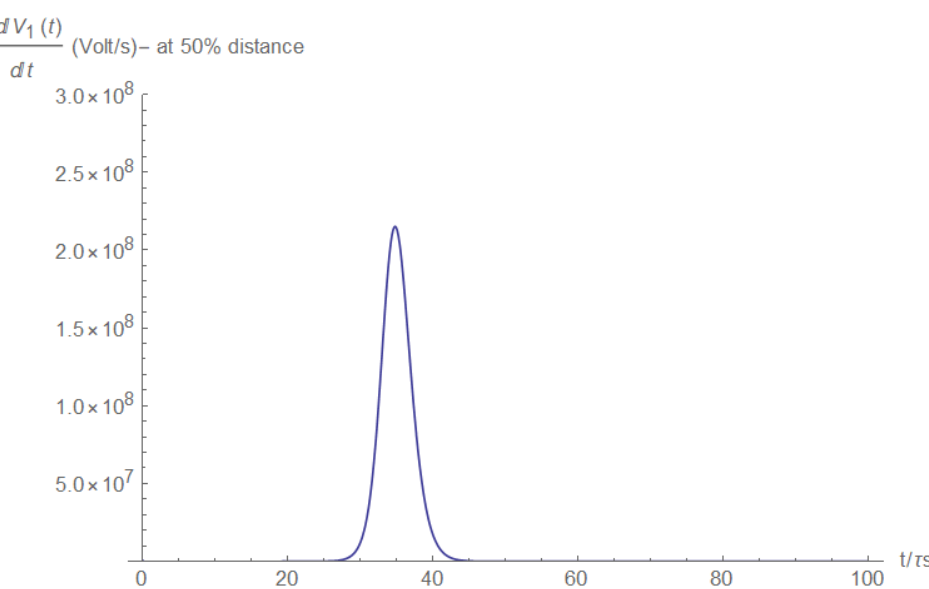
Figure A27. Voltage at half the distance between the source and the short.